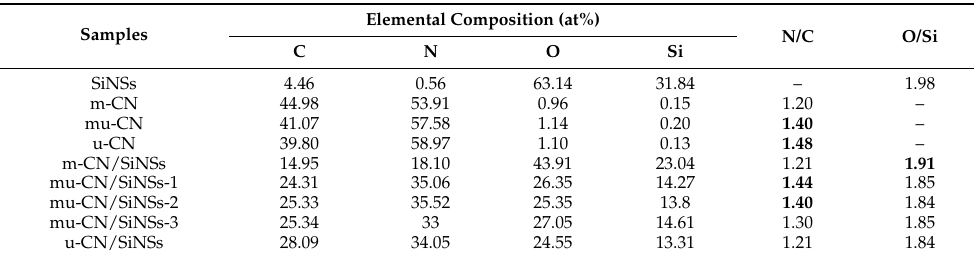
Elemental Composition (at%)